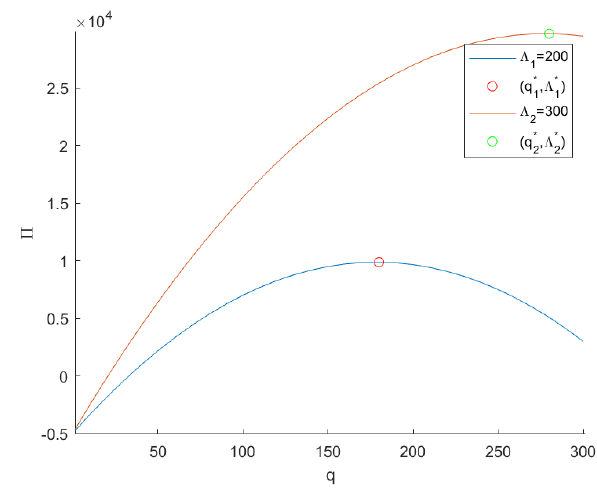
Figure 3. Advertisers’ profits under different numbers of potential users. Note: U 0 = 100, t 1 = 100, t 2 = 20, l = 600, β = 0.1, C a = 5000, k = 1, ρ = 1, τ = 1 .